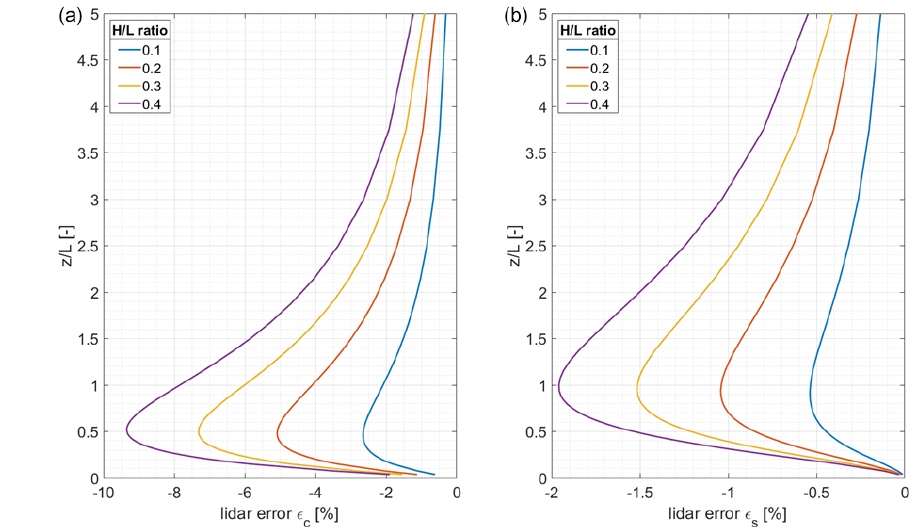
Figure 7. Lidar error ε c (a) and ε s (b) in dependence of the ratio H/L between z/L ratios from 0 to 5. Results are based on the potential flow model. Note the different scaling of the x axes.